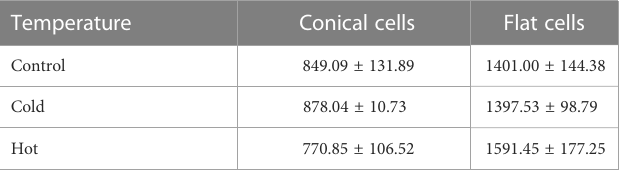
TABLE 1 Cell area in fl owers of A.majus under control, cold and hot conditions. Temperature Conical